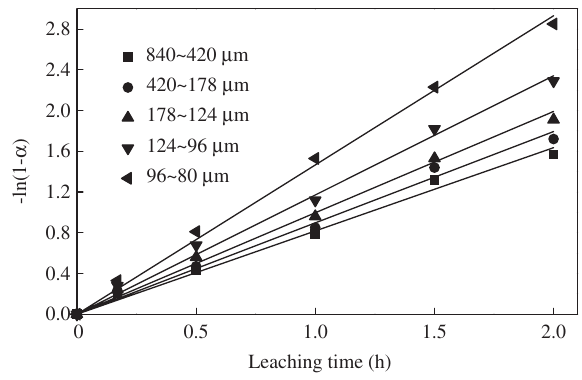
Figure 6: The variation in -ln(1- α ) with time for different particle sizes.